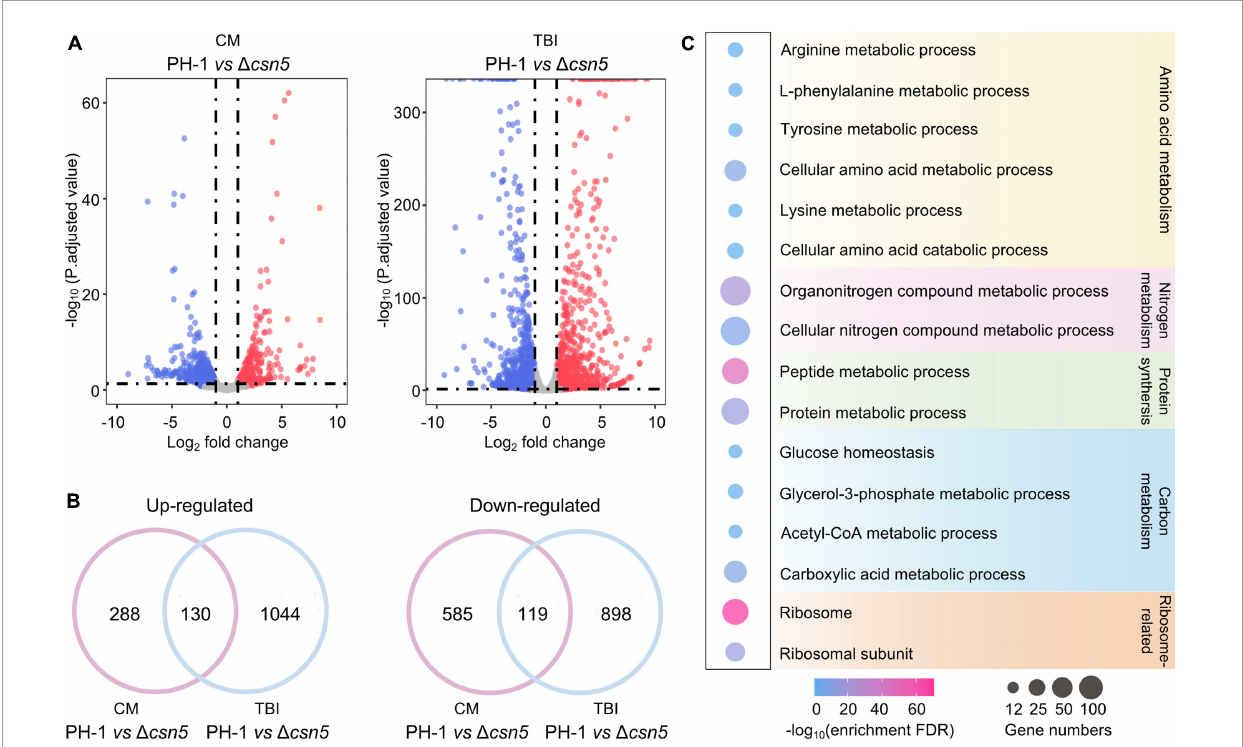
FIGURE6 Transcriptome profiles governed by Csn5 in F. graminearum. (A) Volcano plots showing genes in which the expression was significantly upregulated (red-colored) and downregulated (blue-colored) in the (cid:49) csn5 mutant compared to the wild-type strain PH-1 ( P < 0.05, fold change ≥ 2.0) under nutrient-rich conditions [complete medium (CM)] or toxin induction conditions [trichothecene biosynthesis induction (TBI) medium]. (B) Venn diagrams showing the number of genes in which the expression was significantly upregulated (left panel) or downregulated (right panel) in the (cid:49) csn5 mutant compared with the wild-type strain PH-1 under both nutrient-rich conditions and toxin induction conditions. (C) Enriched gene ontology (GO) terms in genes with downregulated transcripts in the (cid:49) csn5 mutant under nutrient-rich